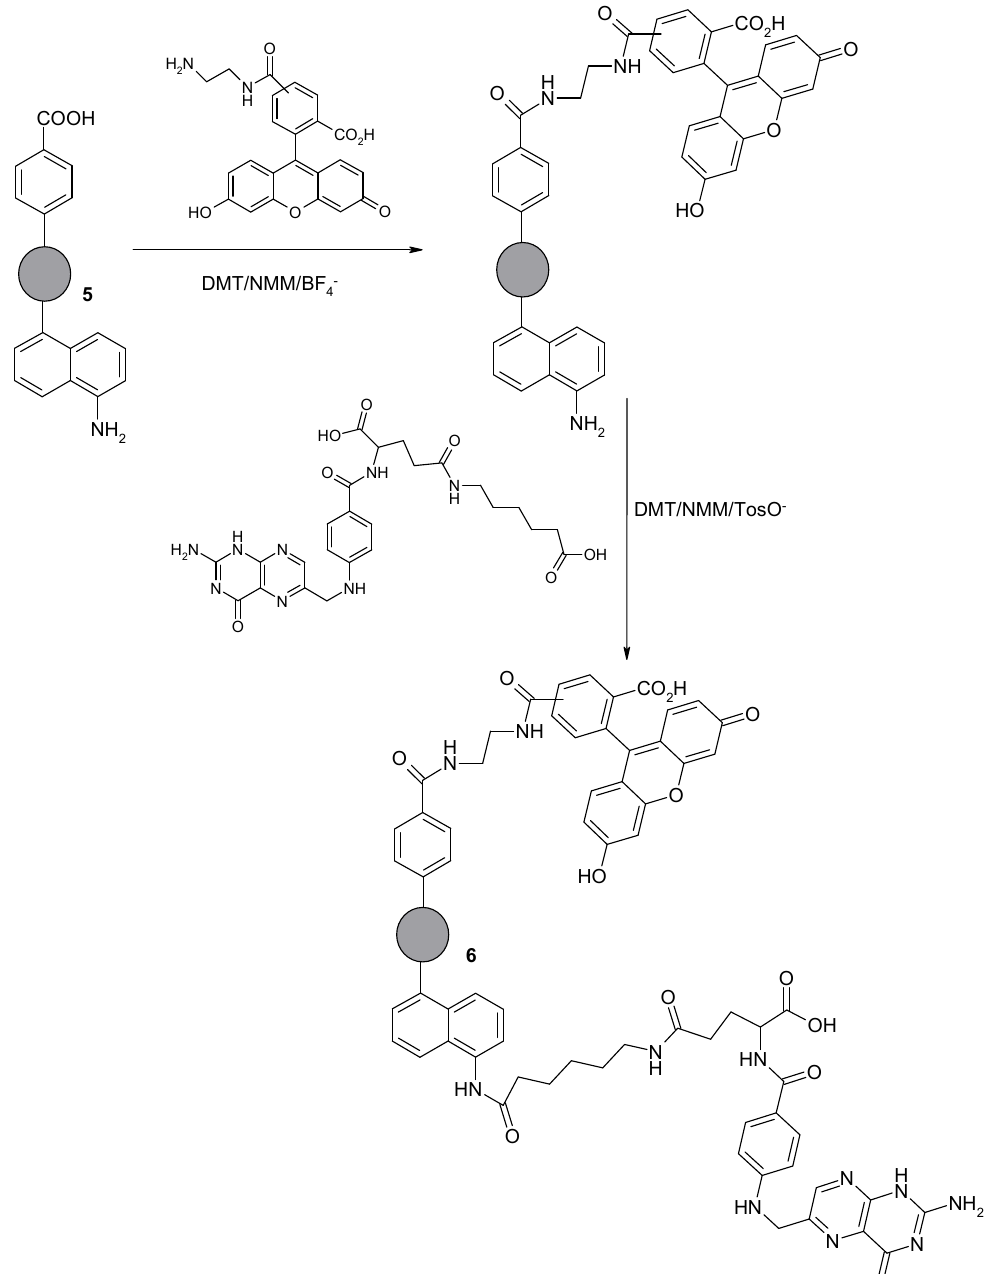
Figure 11. Reaction of the modified NDPs ( 5 ) with folic acid and 5(6)-carboxyfluorescein derivatives. The folic acid residue can be used as a homing molecule with respect to cancer cells, since for many tumors the overexpression of folate receptors is observed. On the other hand, the fluorescent marker allows the tracking of the distribution and interaction of the modified nanomaterial with cells. A triazine condensing reagent (DMT/NMM/BF 4 − and DMT/NMM/TosO − ), a typical reagent used in the synthesis of peptides, was applied for the synthesis of Derivative 6 . Extremely mild coupling reaction conditions (room temperature, no harsh reagents) have been applied for synthetic purposes,